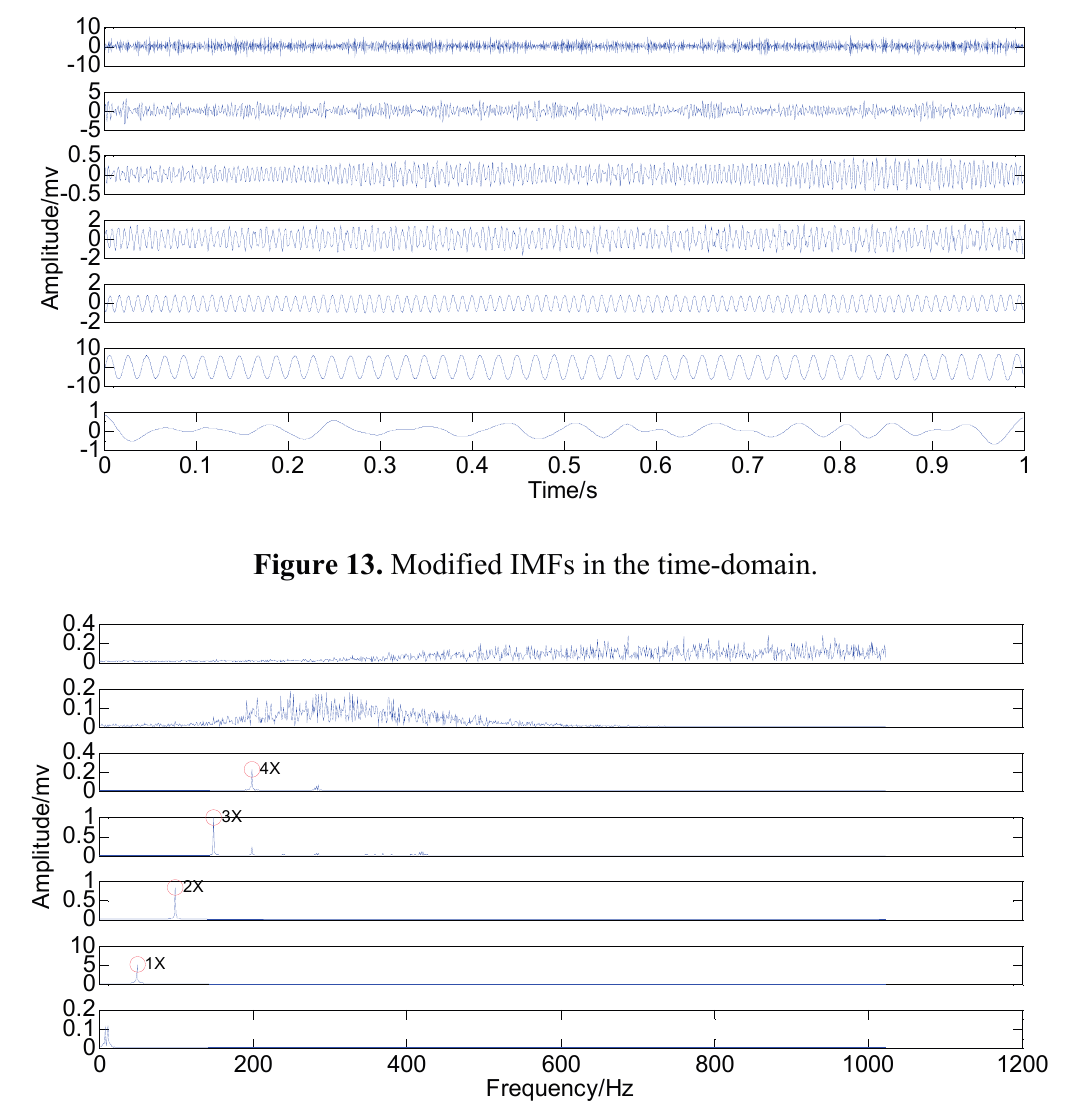
Figure 12. The rubbing signal in the time-domain and the frequency-domain.